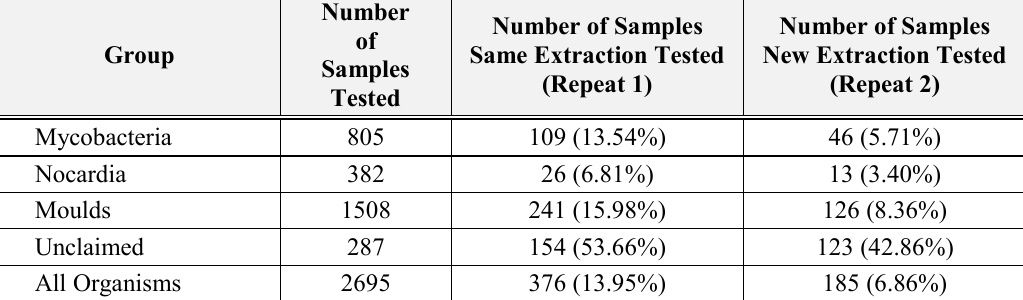
TABLE 17: Repeat rate in clinical